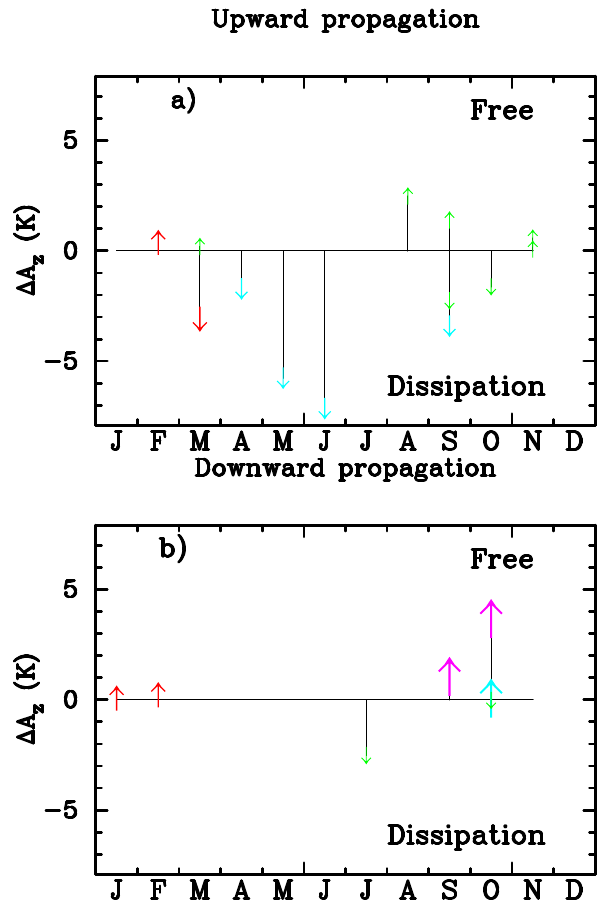
Fig. 8. Amplitude variation (difference between the amplitudes of a simultaneous oscillation detected in the temperatures deduced from both OH and O 2 emissions) as function of the month. Red and normal arrow: 2-day; Green and small arrow: 5-day; Blue and big arrow: 10-day; Pink and huge arrow: 16-day (a) Upward energy propagation. (b) Downward energy propagation.